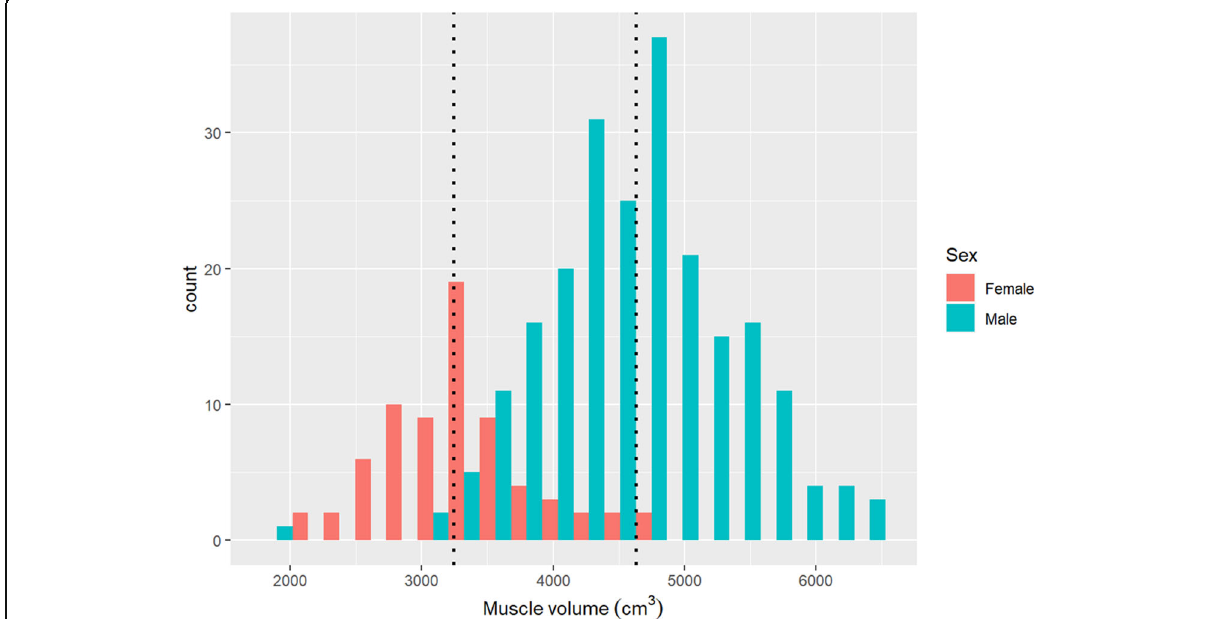
Fig. 2 Histogram of calculated muscle volumes, grouped by sex. The median muscle volume was 3,243 cm 3 for females and 4,629 cm 3 for males (dotted lines)